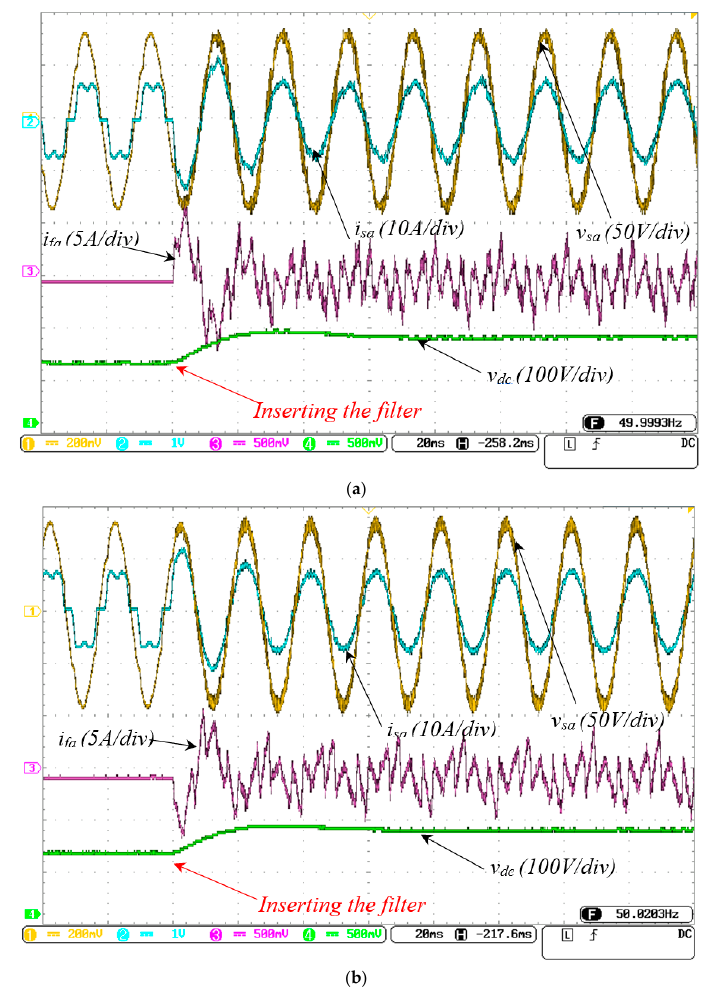
Figure 13. Main parameters of the system at filter insertion by using conventional DPC ( a ) and MPPC-SVM ( b ).